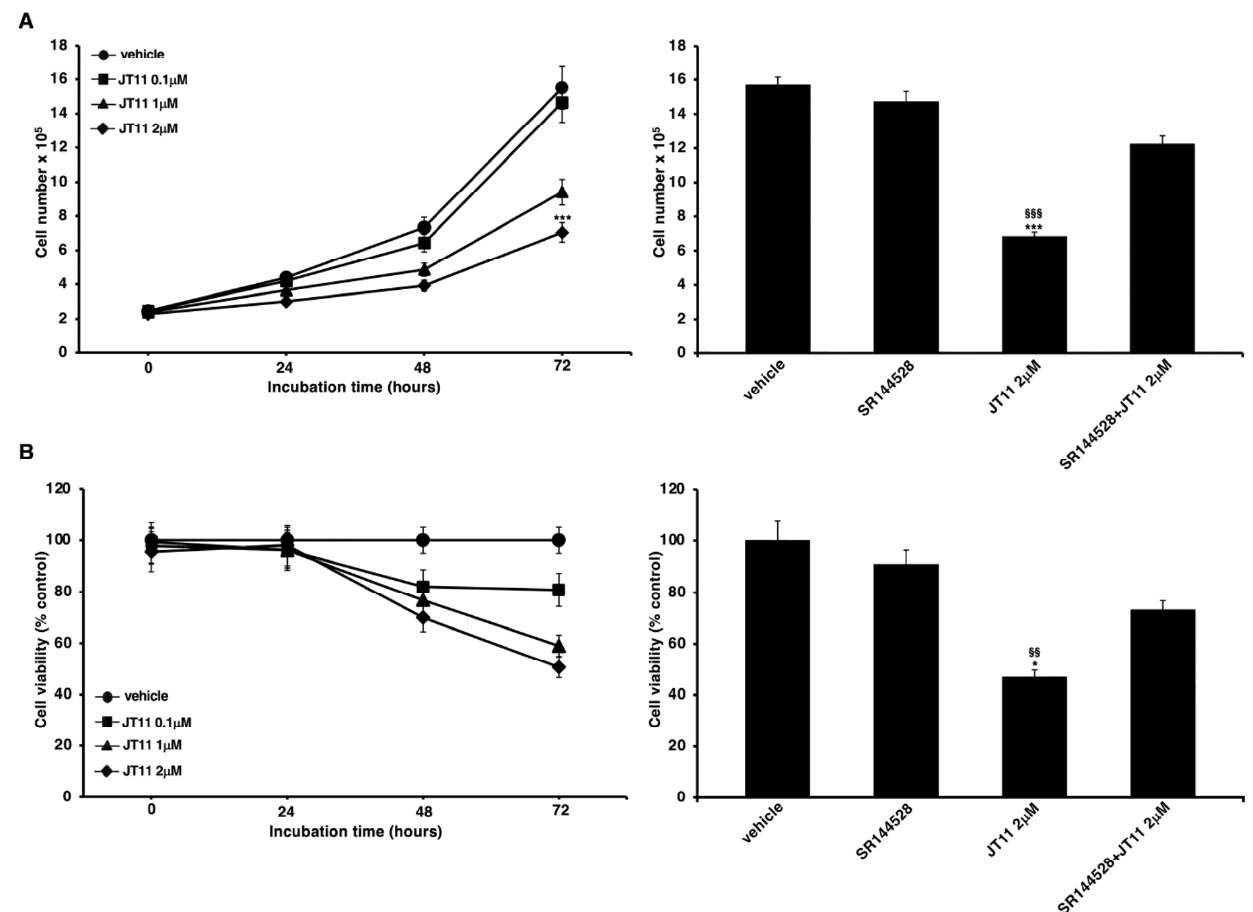
Figure 2. JT11 regulates cell viability and growth through a CB2R-dependent mechanism in Jurkat cells. (( A ), left panel) Jurkat cells were treated with 0.1, 1 or 2 µ M dose of JT11 for 24, 48 and 72 h. The number of viable cells was determined by Trypan Blue assay. Data are reported as the mean ± SD among ten independent experiments. *** p < 0.0001 vs. vehicle; (( A ), right panel) To verify that JT11 acted via CB2R, Jurkat cells were pretreated with CB2R selective antagonist, SR144528 (1 µ M), exposed to JT11 for 72 h and then analyzed for cell viability. *** p < 0.0001 vs. vehicle; §§§ p < 0.0001 vs. SR144528 + JT11; (( B ), left panel) Cell proliferation was measured by 3-(4,5-dimethylthiazol-2-yl)-2,5-diphenyltetrazolium bromide (MTT) assay in Jurkat cells. The results represent the mean ± SD of five independent experiments performed in triplicate and represent cell viability as a percentage of untreated control cells. * p < 0.01 vs. vehicle; (( B ), right panel) Jurkat cells were pretreated with selective CB2R antagonist (SR144528, 1 µ M), exposed to JT11 for 72 h and then analyzed for cell proliferation. * p < 0.01 vs. vehicle; §§ p < 0.001 vs. SR144528 +